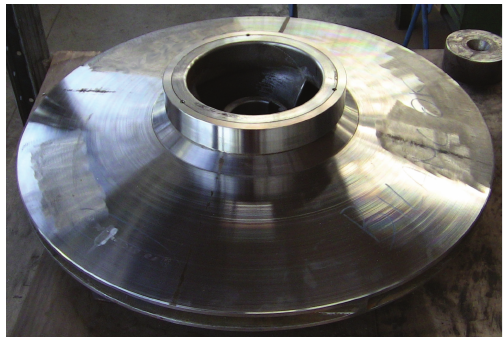
Figure 6: The N s = 10 . 9